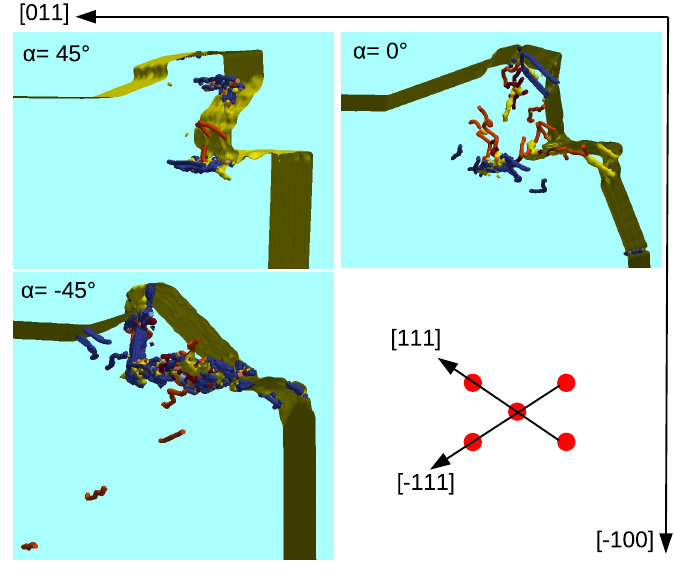
Figure A1. Side view of the dislocations generated in the Fe (100)[011] cutting system at cutting length 100 Å with a cutting tool of rake angles 45 ◦ , 0 ◦ , and − 45 ◦ . Dislocations and slip directions are denoted as in Figure